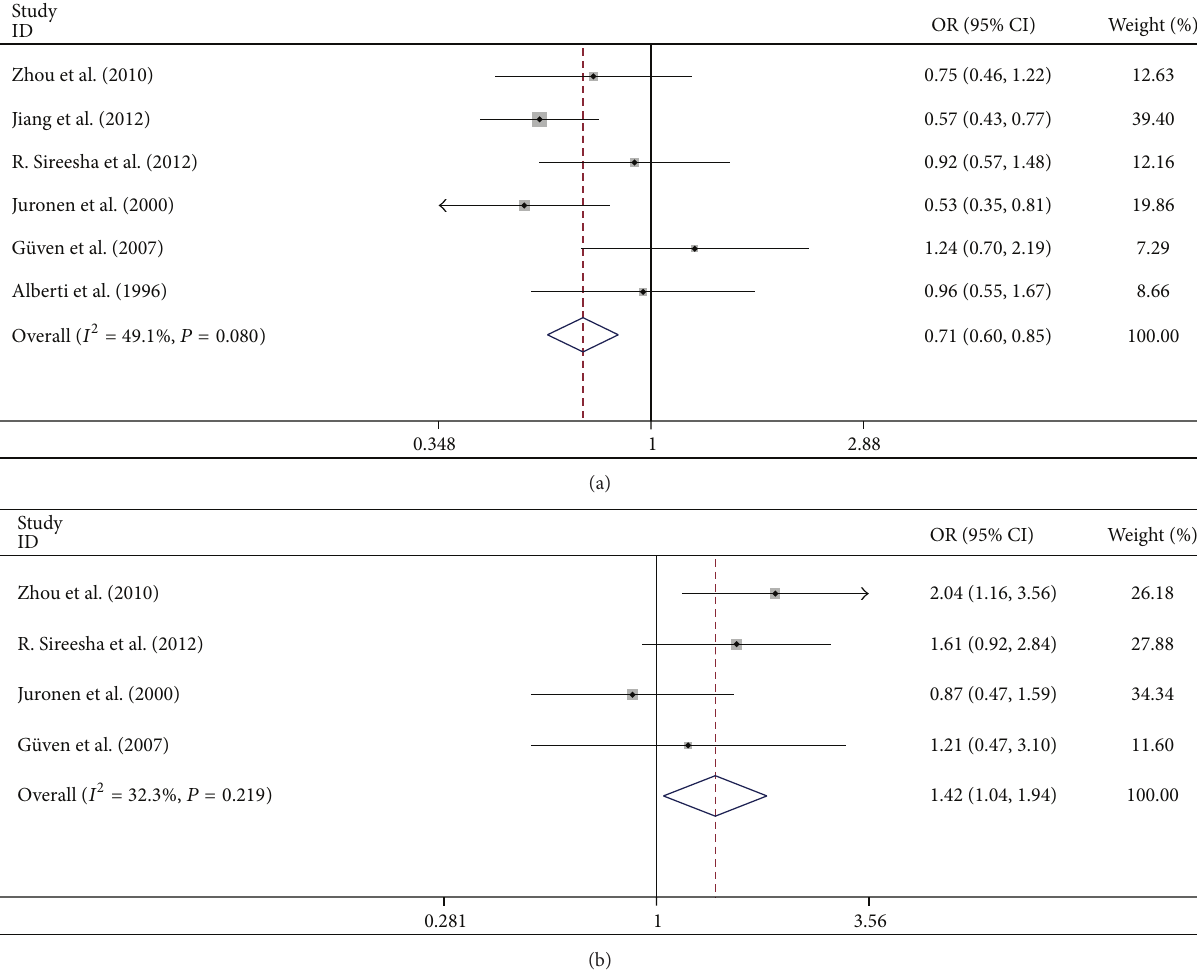
Figure 4: Subgroup analysis of the correlation between GSTM1 / T1 null genotype and subtypes of age-related cataract (ARC). (a) Subgroup analysis of the association between GSTM1 null genotype and cortical cataract (CC). (b) Subgroup analysis of the association between GSTT1 null genotype and posterior subcapsular cataract